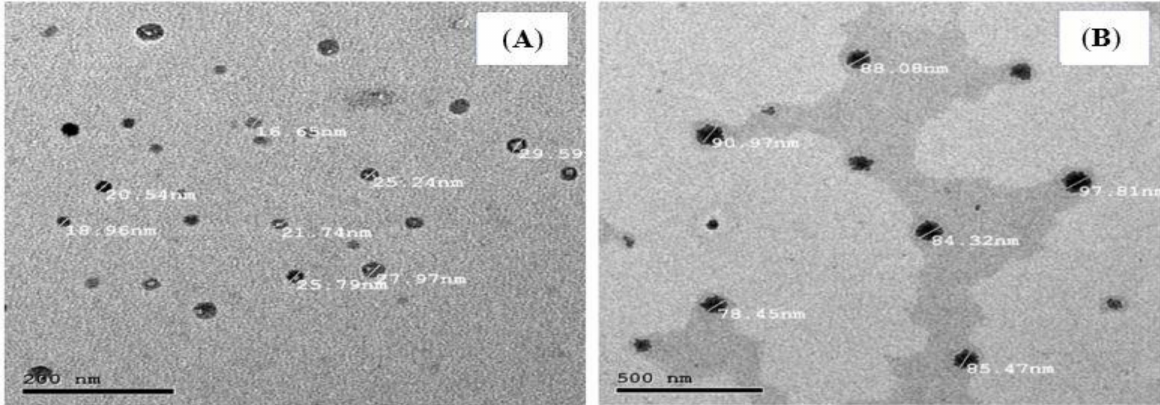
Figure 6. TEM photographs of Fr-SNEDS freshly prepared ( A ) and stored ( B ) formulation under ambient conditions for 12